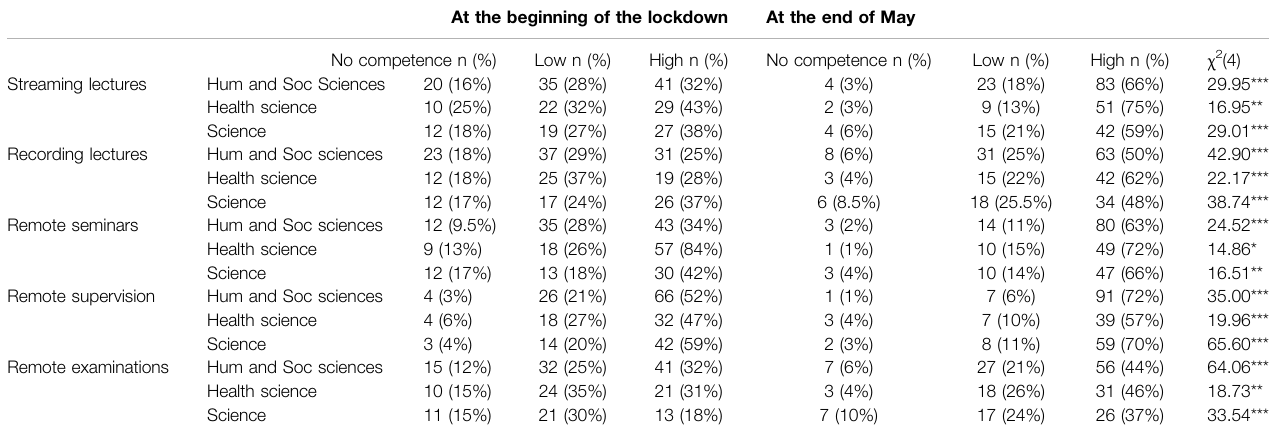
TABLE 3 | Competence in remote teaching at the beginning of the lockdown and at the end of May based on academic fi eld and a summary of the Chi-Square tests. At the beginning of the